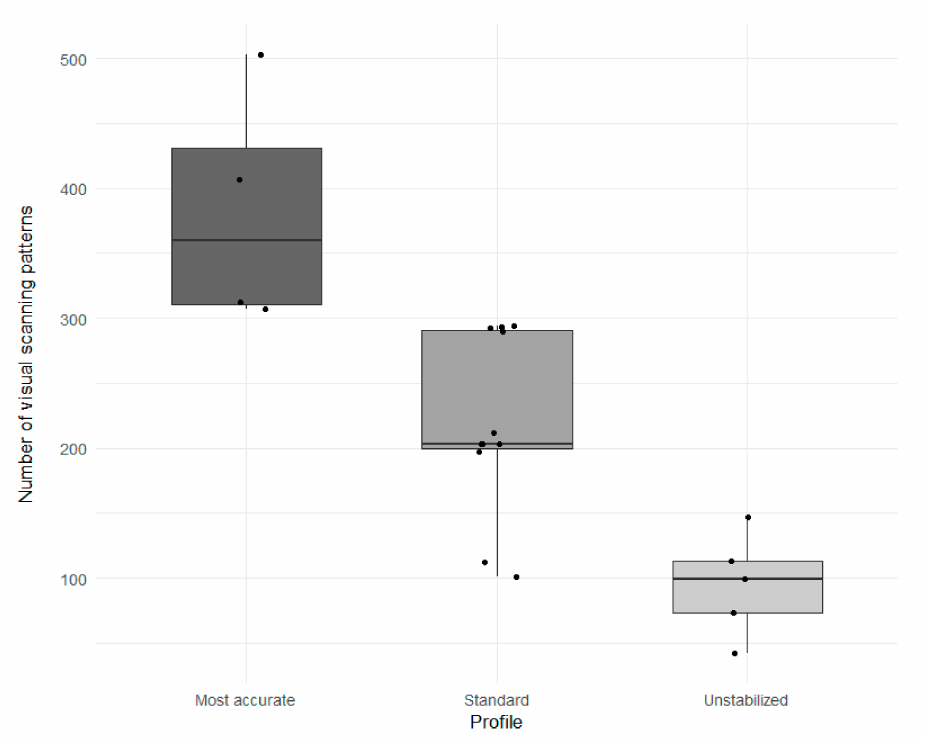
Figure 9. Number of visual scanning patterns according to the three pilot’s performance profiles (dots represent individual data) during the approach (pre-training session). The most accurate pilots produced a higher number of visual scanning patterns, followed by the standard pilots, and the unstabilized pilots.